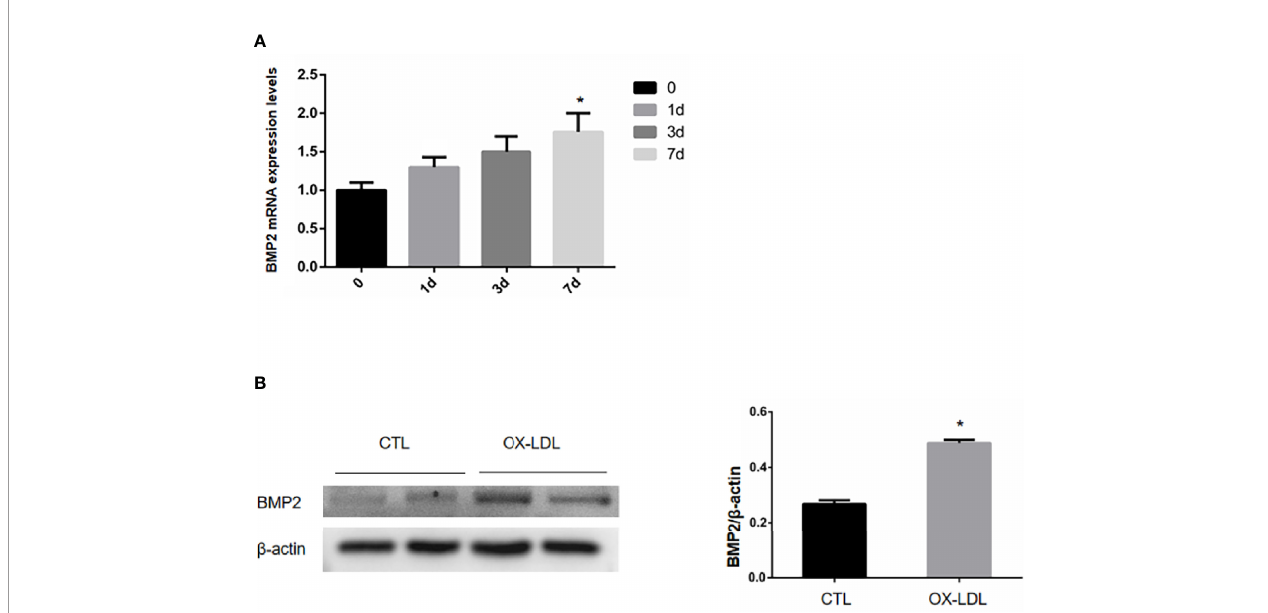
FIGURE 2 | mRNA and protein expression levels of BMP2 in VIC after ox-LDL stimulation. (A) The relative expression of BMP2 mRNA under different time stimulation; (B) BMP2 protein expression in VICs after ox-LDL stimulation. * represents P value less than 0.05, indicating signi fi cant difference.